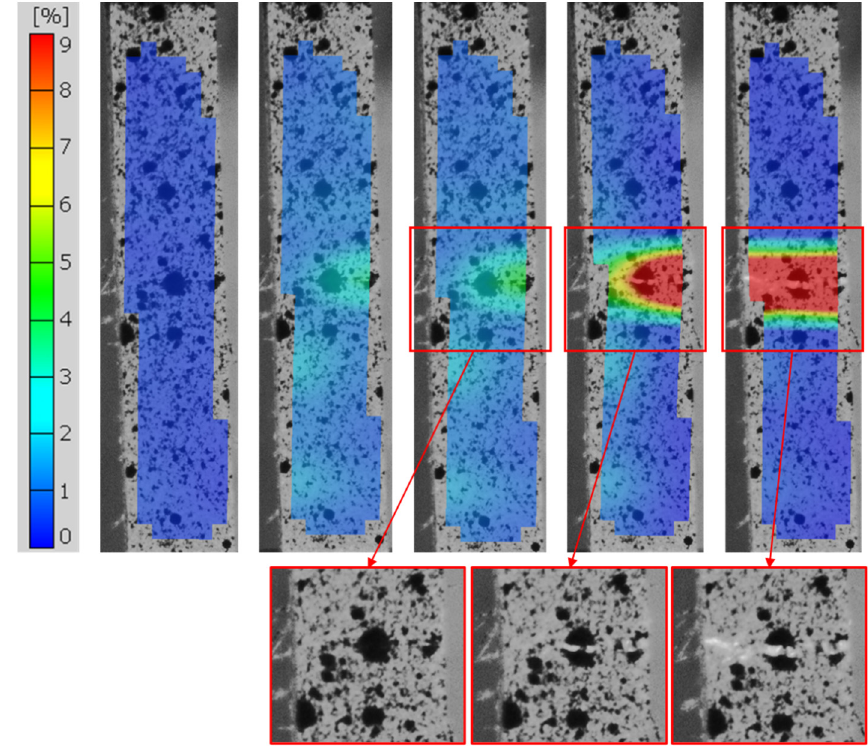
Figure 4. Images of major strain distribution at different loading stages for hybrid 2 composite.